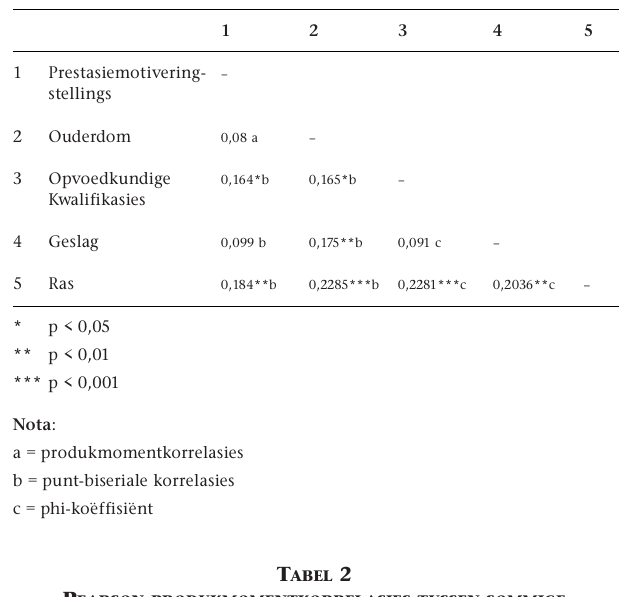
Tabel 2 aangedui word. Die resultate van meervoudige regressieontledings word in Tabel 3